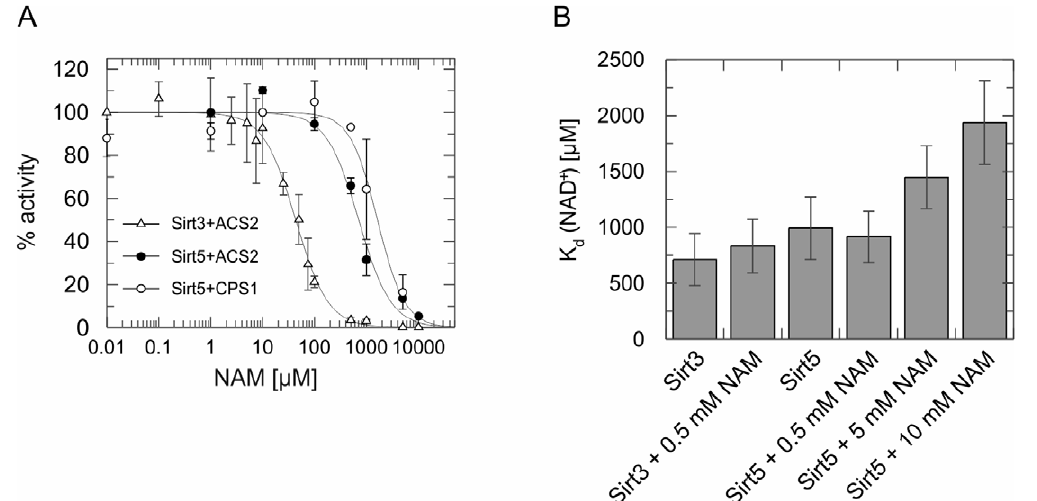
Figure 2. The mass spectrometry-based deacetylation assay reveals an unusual low Sirt5 sensitivity for nicotinamide inhibition. ( A ) Dose-dependent nicotinamide inhibition of the deacetylation of an ACS2 or CPS1 peptide, respectively, by Sirt3 and Sirt5. % activity was determined through relative quantification of reaction product by mass spectrometry and normalization to the respective non inhibited activity (set to 100%). Error bars represent standard errors for three independent measurements. ( B ) Dissociation constants for the interaction of NAD + with Sirt3 and Sirt5, respectively, in presence of different nicotinamide concentrations. K d values were determined by microscale thermophoresis measurements. Error bars represent standard errors of three independent measurements. NAM,